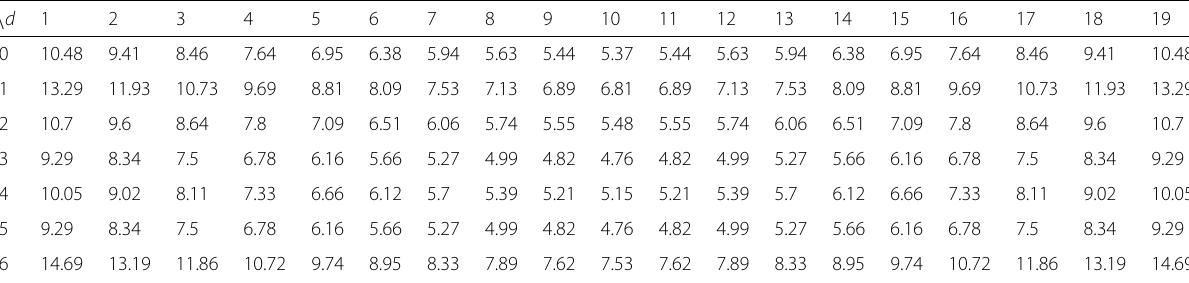
Table 10 Estimated values of the variance of the error distributions for the previous-day demand predictions t \ d